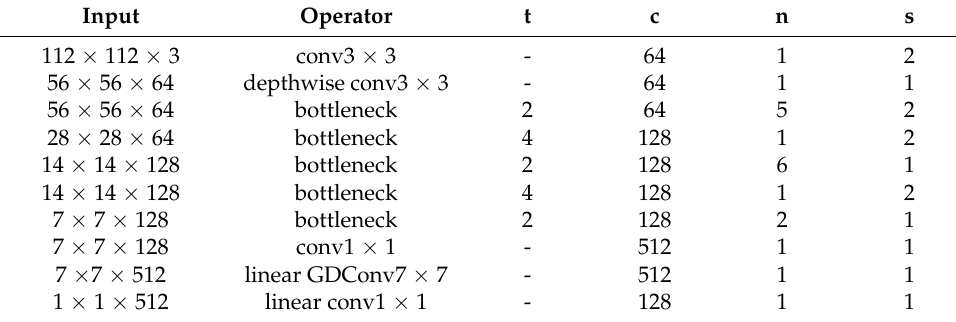
Table 1. MobileFaceNet [15] architecture. Each line describes an operator composed of convolutional kernels and the operators in the table are executed from top to bottom in the process of network inference. The “Input” column corresponds to the size of the input feature map, which is calculated by the operators of the previous layer; the columns of t, c, n, and s correspond to the parameters of each operator. The parameter t is the expansion factor, the parameter c is the number of output channels, the parameter n represents the number of repetitions, and the parameter s represents stride, which means the sliding step of the convolution kernel, and can be used to down-sample the input feature